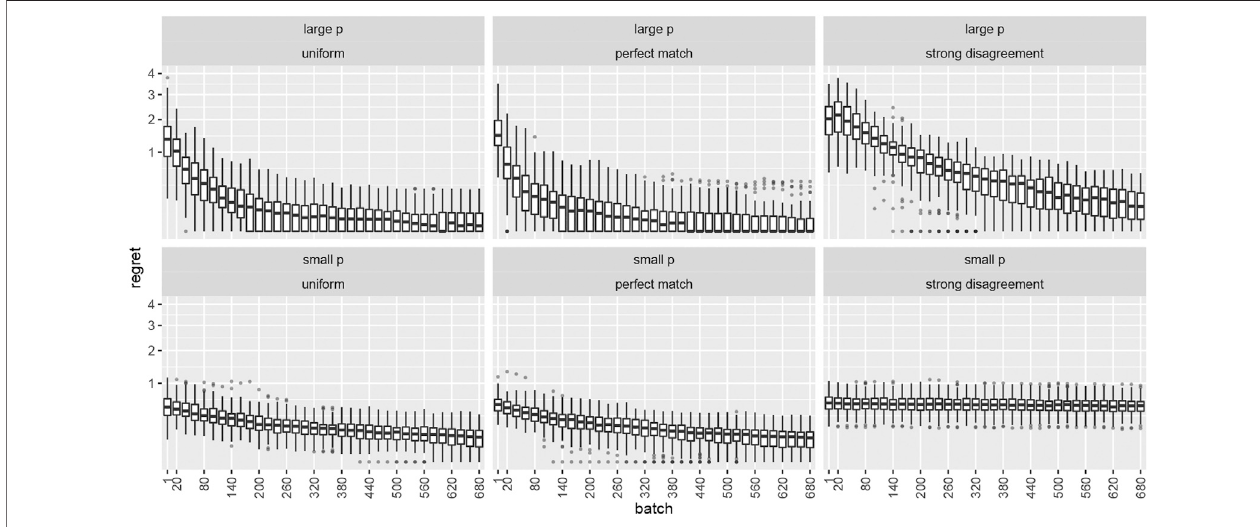
FIGURE 1 | Boxplots depicting expected regret per time period L t for (top row) large and (bottom row) small effect sizes. The columns correspond to the three assumed priors outlined in the main text.